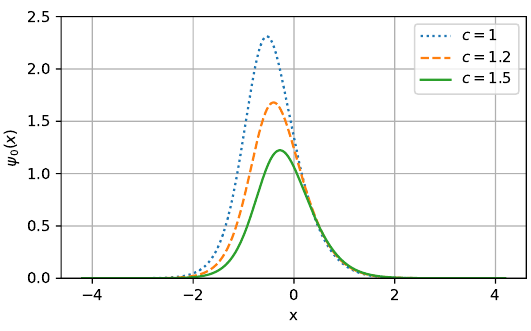
Figure 4 . Plots of ψ 0 ( x ) for the polynomial model with κ = 1 , c = 1 , 1.2 and